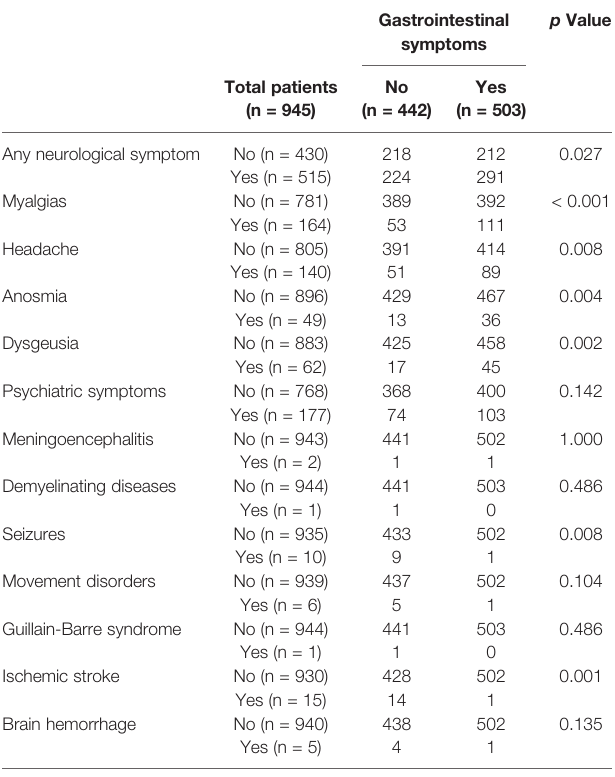
TABLE 1 | Relationship of neurological complications and gastrointestinal symptoms during the course of coronavirus disease